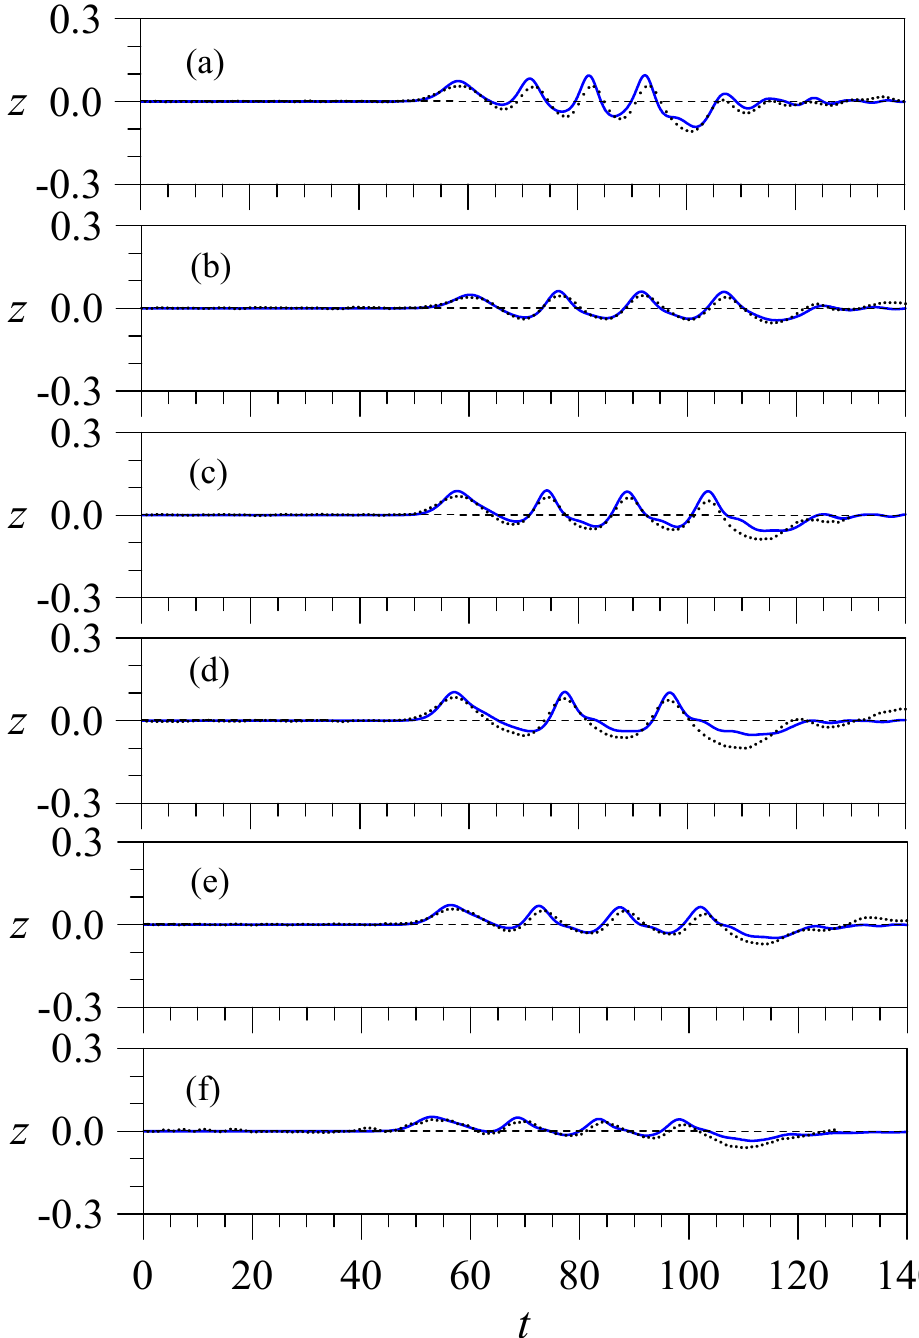
Figure 4. Comparisons of time variation of transmitted waves between the present CAN model solutions ((solid-blue lines) and experimental data (black-dotted lines) for cnoidal waves encountering a partially submerged body for various input parameters, ( a ) α = 0.3, λ = 10, h 1 = 0.2, L = 4, (RMSE = 0.0149) ( b ) α = 0.15, λ = 15, h 1 = 0.2, L = 4, (RMSE = 0.00753) ( c ) α = 0.3, λ = 15, h 1 = 0.5, L = 4, (RMSE = 0.034) ( d ) α = 0.3, λ = 20, h 1 = 0.5, L = 4, (RMSE = 0.02) ( e ) α = 0.3, λ = 15, h 1 = 0.5, L = 6, (RMSE = 0.0122) and ( f ) α = 0.3, λ = 15, h 1 = 0.5, L = 10 (RMSE = 0.011).